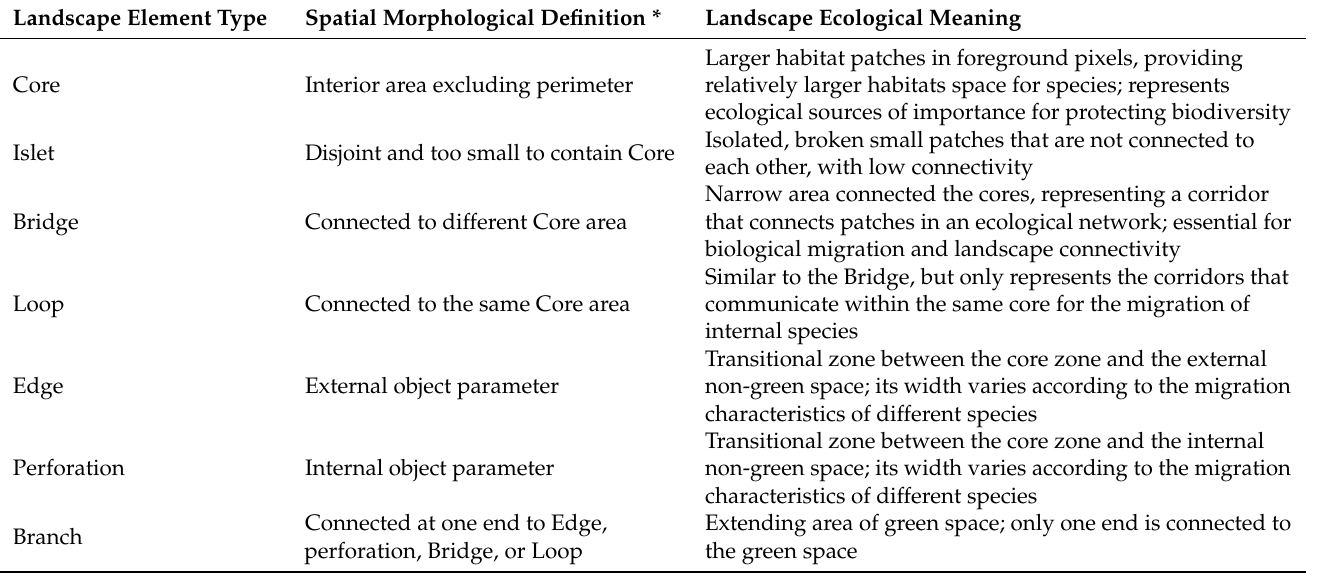
Table 1. Descriptions of the seven MSPA element types under mathematical and landscape ecological meaning. Landscape Element